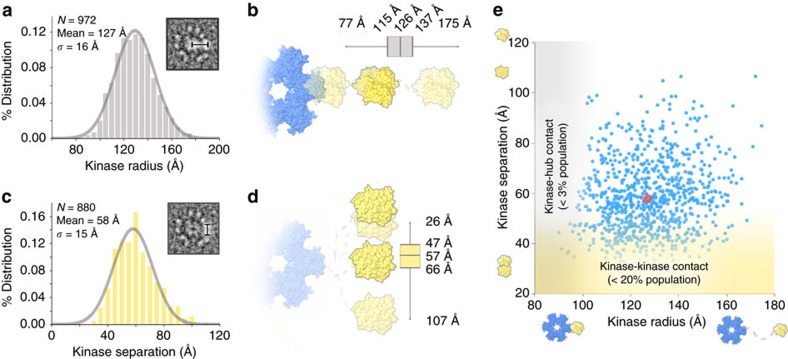
Structural diversity of CaMKIIα kinase domain arrangements measured from single particle images.(a) Histogram of measured radius for individual kinase domains. A Gaussian curve fit to the histogram distribution is shown (grey line). (b) Illustration and whisker plot representation of the distribution of kinase radius measurements in a. Kinase domains (yellow) are illustrated to represent the minimum, maximum and average distance from the hub domain complex (blue). (c) Histogram of measured distance separating neighbouring kinase domains (center-to-center). A Gaussian curve fit to the histogram distribution is shown (grey line). (d) Illustration and whisker plot representation of the distribution of kinase separation measurements in c. Kinase domains are illustrated to represent the minimum, maximum and average kinase separation distances. Inset, in a,c illustrate the distance measurement made using raw particle images. Whiskers in b,d indicate the minimum and maximum values, and boxes indicate the 25%, 50% and 75% values of the distribution. (e) Correlation map of kinase radius versus kinase separation distance. This analysis revealed no statistical correlation between these values (correlation coefficient=0.2). The average of the two parameters is shown in red. Grey and yellow shading indicates regions of the correlation map where kinase domain positioning is consistent with steric contact with the hub domain and/or kinase-kinase contact, respectively.